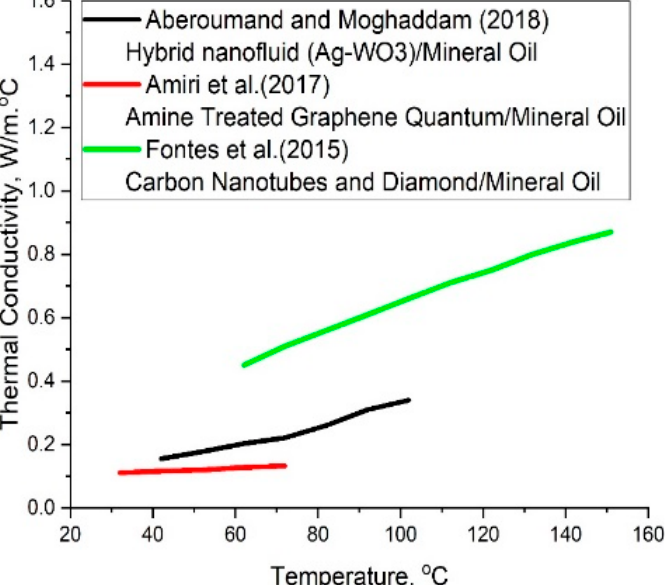
Figure 5. Comparison of thermal conductivity vs. temperature with nanoparticle concentration.